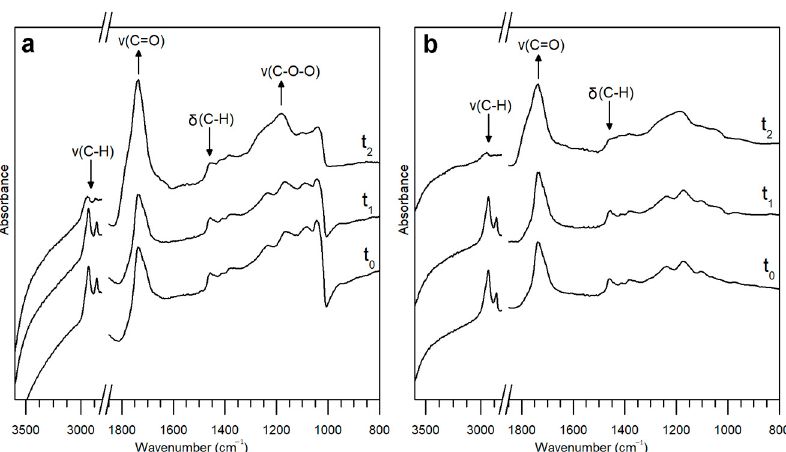
Figure 13. Representative reflection FT-IR spectra, after KK transformations, collected on the mock- ups m.B ( a ) and m.F ( b ) at different aging times: t 0 (dried), t 1 (25 h), t 2 (425 h). Arrows indicate the main change observed and discussed in the text. Table 3. Assignment of the KKT bands of the linseed-oil colophony varnish [67] at different aging times: t 0 (dried), t 1 (25 h), t 2 (425 h). The spectral study was limited to the region not interested by artefacts, and the precise wavenumber values of the KKT band maxima derived from the second- derivative analysis. Abbreviation (sh) corresponds to shoulder